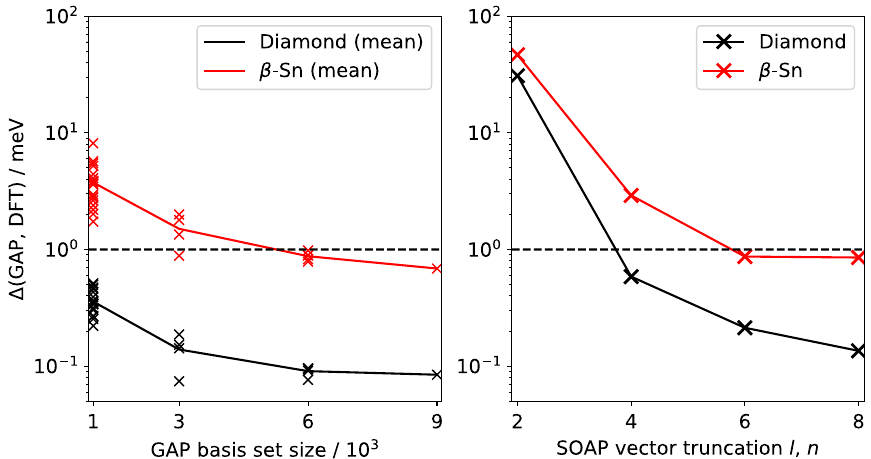
FIG. 4. Error of the SOAP or GAP model based on the Δ value of Ref. [162] with respect to the DFT for diamond (black) and β -Sn (red) structures. The left shows the error as a function of the number of basis functions used in the Gaussian process regression. Because we use a stochastic algorithm to select which basis functions to use, multiple models are shown, which differ only in the pseudorandom seed. The right shows the error as a function of the length of the SOAP vector, which in our case is controlled by the truncation of the radial and spherical harmonic expansion of the atomic neighbor density. The horizontal dashed line corresponds to 1 meV per atom error, our default energy accuracy